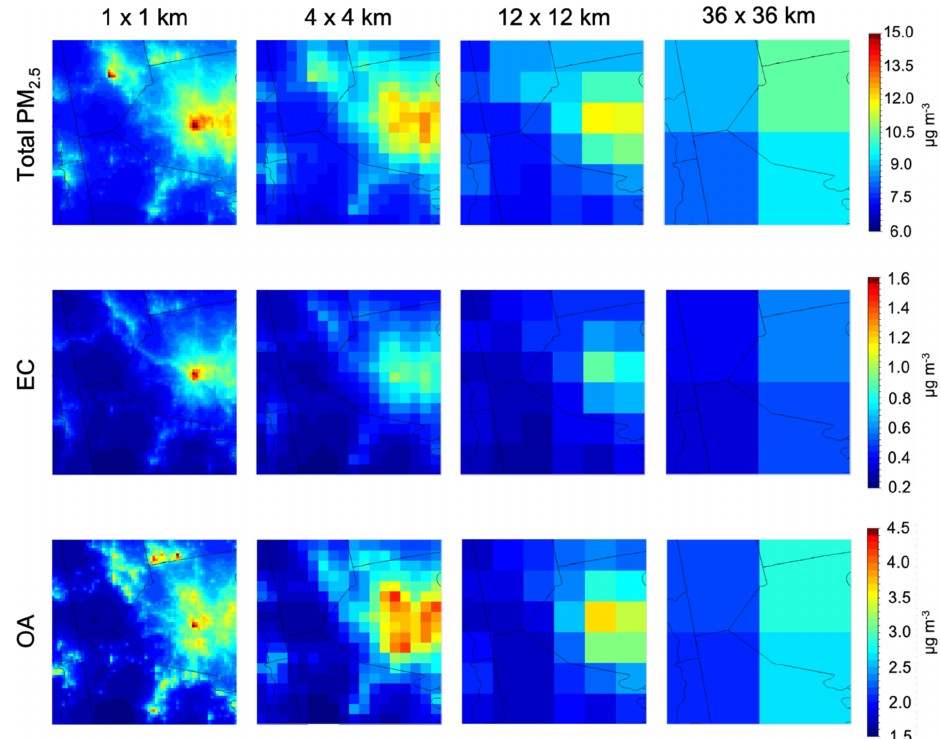
Figure 3. Average predicted ground-level concentration of total PM 2 . 5 , EC, and OA at 36 × 36, 12 × 12, 4 × 4, and 1 × 1km resolutions during February 2017. Different color scales that do not start from zero are used for the various